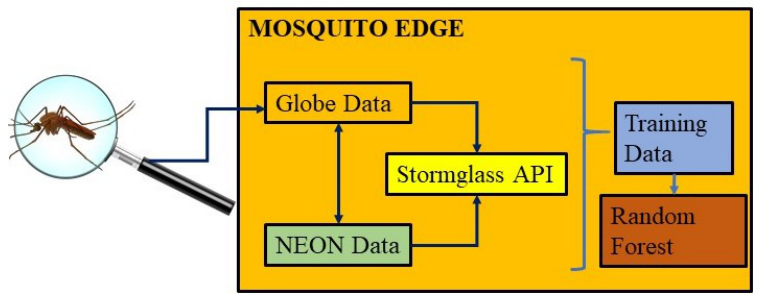
Figure 1. Overview of the proposed method in MOSQUITO EDGE